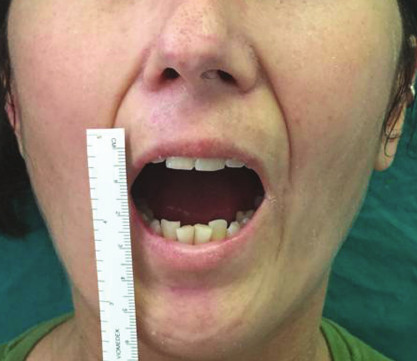
Figure 1: A 39-year-old woman with microstomia before